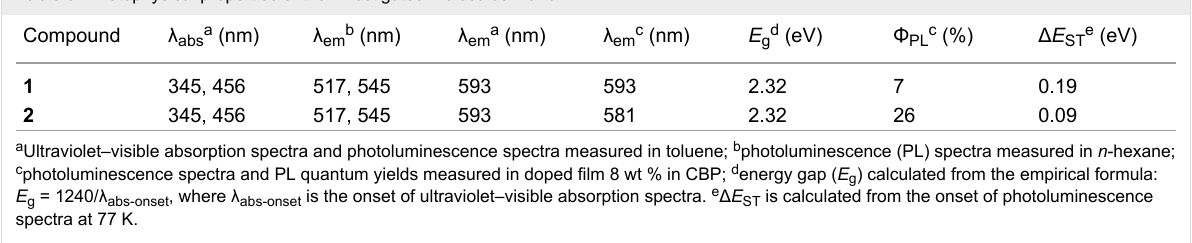
Table 3: Photophysical properties of the investigated molecules 1 and 2